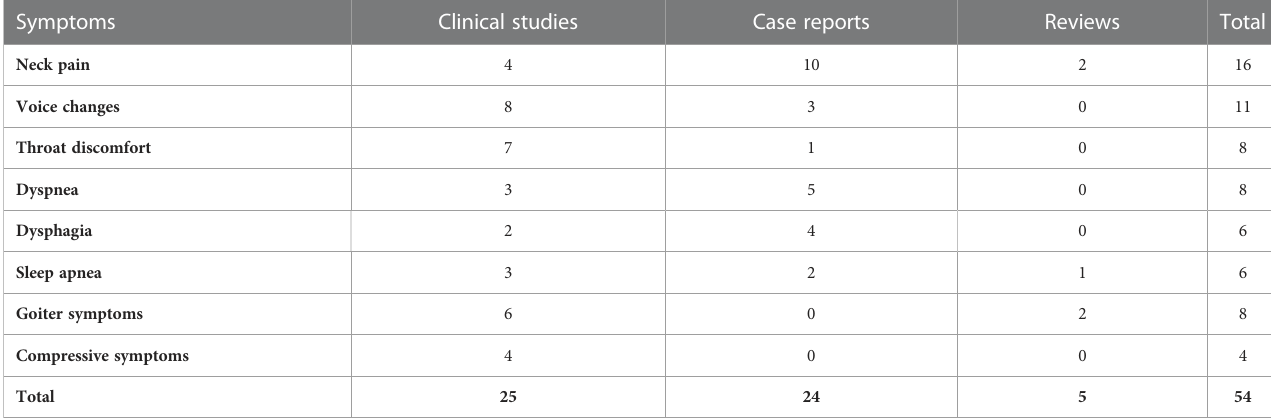
TABLE 2 Distribution of local